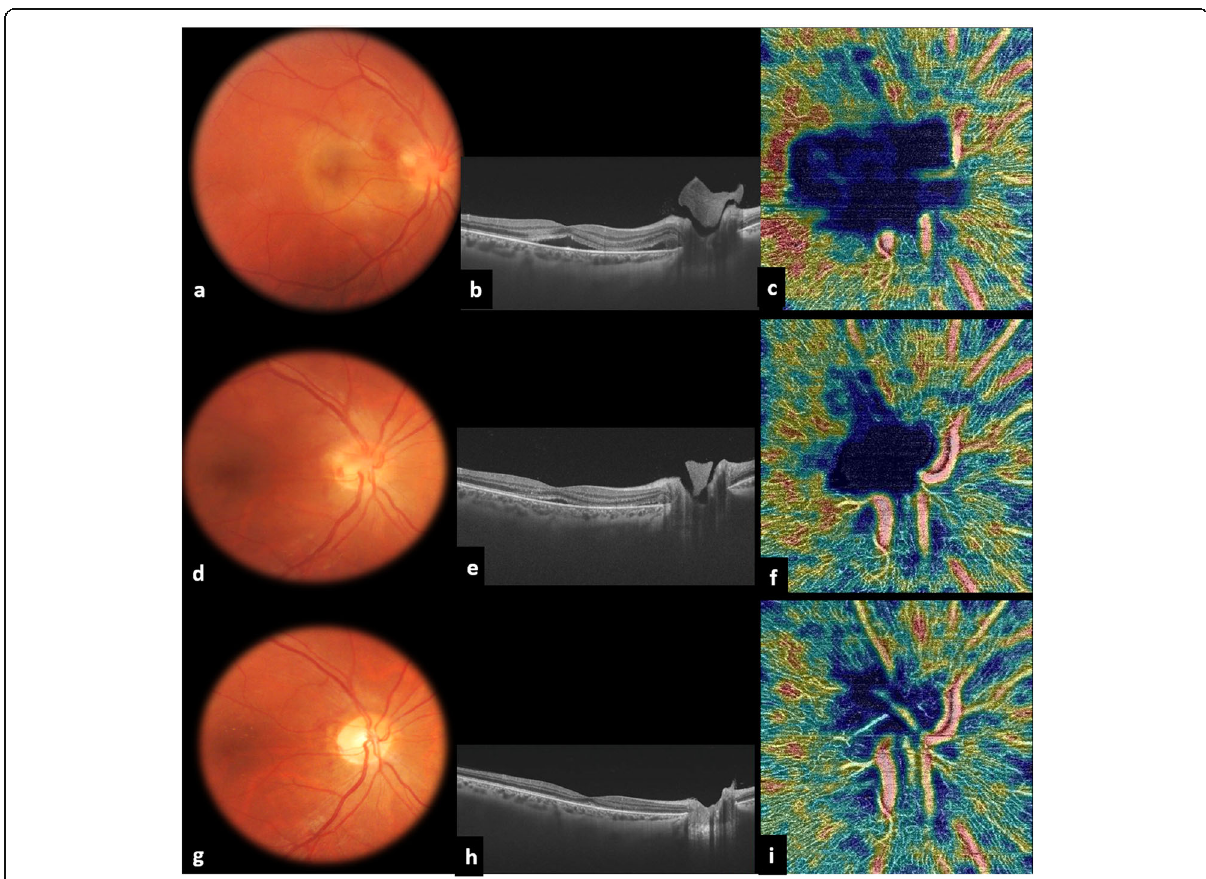
Fig. 2 Multimodal imaging at the time of presentation for the right eye involvement. a Fundus photograph of the right eye showing a localized inflammatory vitreous exudate overlying an infiltrated optic disc and peripapillary retina with associated retinal hemorrhages. b SS OCT showing a “ mushroom-shaped ” hyperreflectivity of the prepapillary vitreous exudation associated with a peripapillary serous retinal detachment involving the fovea. c SS OCTA scan through the radial peripapillary capillary network of the right eye revealing a prepapillary hypointense area due to blockage from the prepapillary exudate. Note the presence of peripapillary retinal hypervascularity, with a peripapillary vascular density (PVD) of 11.23%. Sequential imaging follow-up at 48 h ( d , e , f ) and 1 month ( g , h , i ). Fundus photography showing the development of macular hard exudates and gradual resolution of the prepapillary inflammatory exudate and associated optic disc and peripapillary infiltration ( d and g ). SS OCT demonstrating gradual resolution of the prepapillary hyperreflectivity and subretinal fluid ( e and h ). SS OCTA showing gradual resolution of the prepapillary hypointense area and peripapillary hypervascularity, with a PVD of 9.18% at 1 month ( h , i